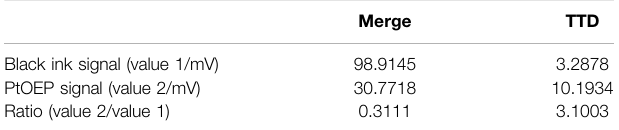
TABLE 1 | Merge image and TDD image signal value